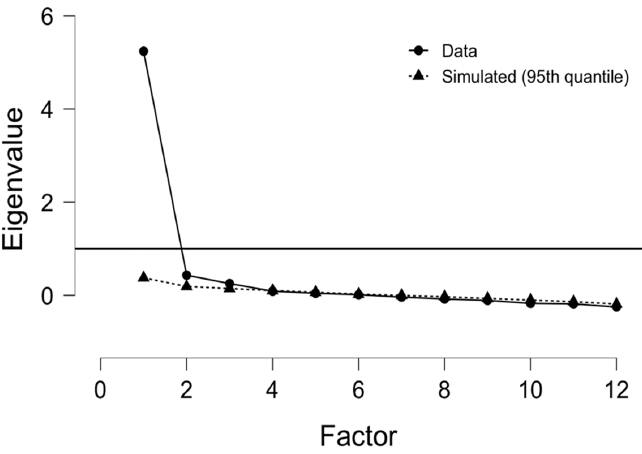
Figure 5. Scree plot for exploratory factor analysis.